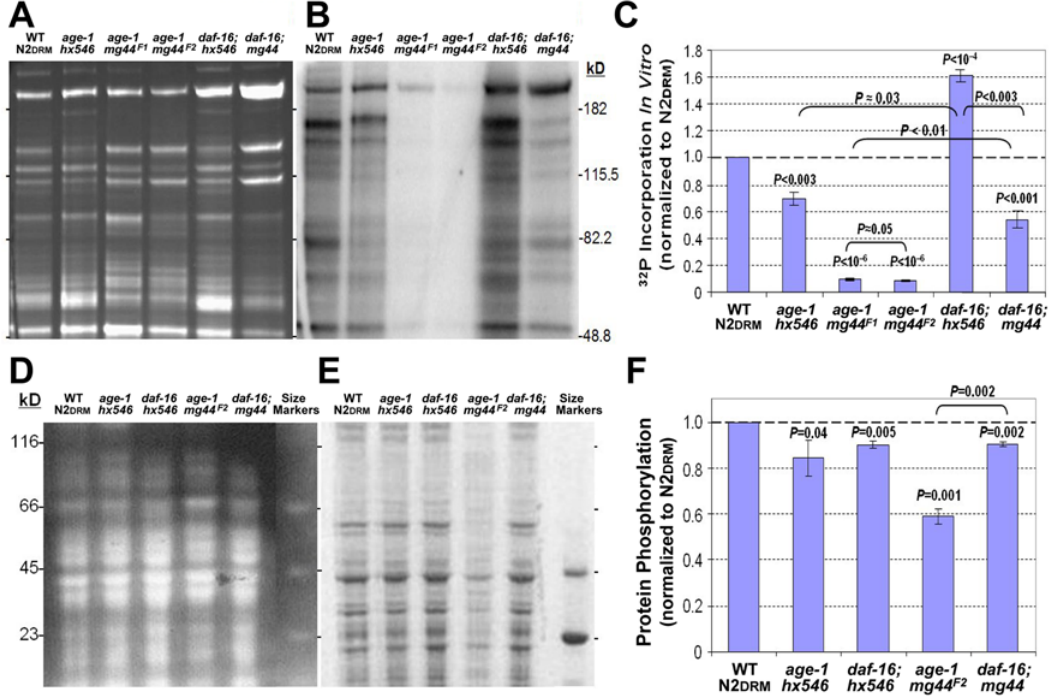
Figure 1. Both invitro kinase activity for endogenous substrates and total phosphoprotein levels are diminished in age-1(mg44) homozygotes. (A–C) In vitro kinase activity of post-gravid or sterile adult worms, 6 days after the L4/adult molt. Kinase activity of cleared, sonicated lysates was assessed as c - 32 P-ATP incorporation per 20- m g protein sample, in 1 min at 30 u C. Samples, quenched on ice, were electrophoresed on 10% polyacrylamide-SDS gels (Invitrogen). (A) Gels stained with SYPRO Ruby (Invitrogen) to confirm constant protein loads. (B) Image of 32 P b -emissions (Molecular Dynamics Storm) from the gel in A, dried under vacuum. (C) Data summary from 2–3 independent expansions each of N2DRM, age- 1(hx546) , age-1(mg44) F1 homozygotes (labeled age-1mg44 F1 ) , age-1(mg44) F2 homozygotes (labeled age-1mg44 F2 ), and daf-16(m26) double mutants with each age-1 allele. These quantitations covered the full length of each lane, not all of which is shown in A and B. (D–F) Phosphoproteins, resolved by polyacrylamide gel electrophoresis and visualized by Pro-Q Diamond staining. (D) Image of total protein stained with Coomassie blue. (E) Image of fluorescence after Pro-Q Diamond staining; note that only the two phospho protein markers were detected. (F) Summary of data from 3 independent expansions of each strain at adult day 6. Significance: (C, F), P values are shown for 2-tailed t -tests (unequal variance) comparing each age-1 strain to N2DRM (values directly over bars) or comparing two strains connected by brackets (values over brackets).